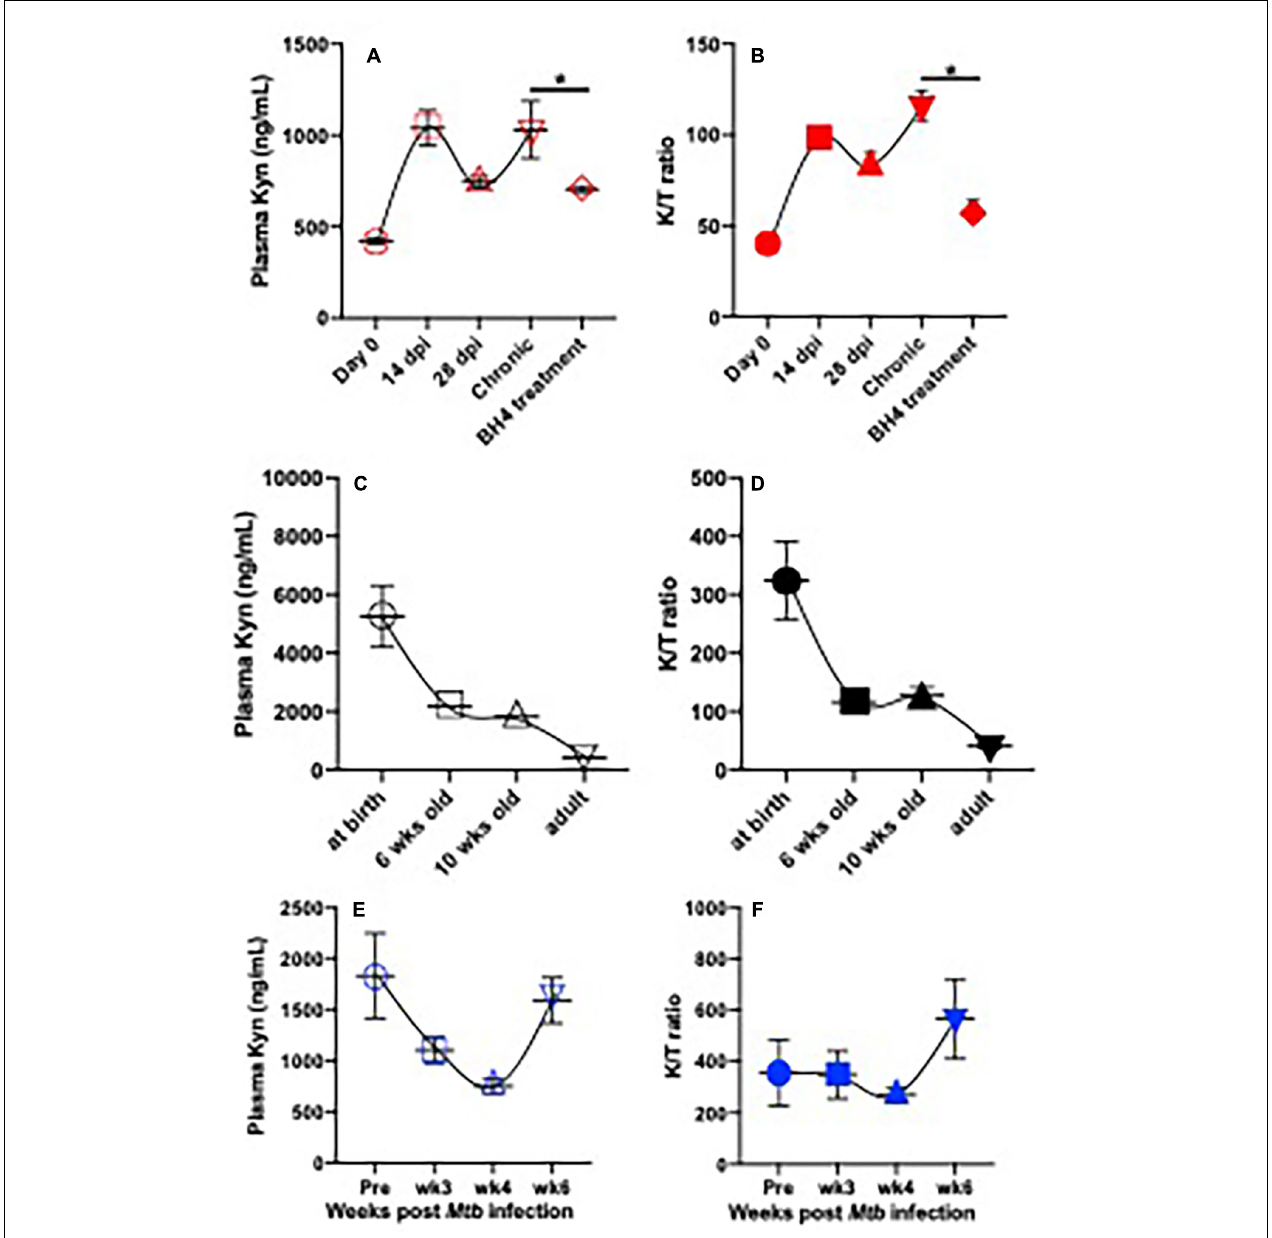
FIGURE 1 | Plasma IDO activity and kynurenine metabolite in SIV-infected adult rhesus macaques on BH4 treatment and their changes with ages or in infant macaques post Mycobacterium tuberculosis infection. (A,B) Dynamics of plasma Kyn and IDO activity (K/T ratio) in adult animal post SIV infection and effects of BH4 treatment on plasma Kyn levels and IDO activity; Indian rhesus macaques ( n = 4) were intravenously inoculated with SIVmac251 at 100TCID50. In chronic SIV infection ( > 3 months postinfection), macaques orally received BH4 (10 mg/kg/day, Schircks Laboratories, St. Gallen, Switzerland) for 1 month. ∗ p < 0.05, compared with untreated animals at chronic stage. (C,D) Dynamics of plasma Kyn and K/T ratios in animals with age; (E,F) dynamics of plasma Kyn and K/T ratio in infant macaque post Mtb infection. Infant macaques ( n = 3) were inoculated with 20 colony-forming units (CFUs) of M. tuberculosis CDC1551 by aerosol route. Plasma was collected to measure levels of Kyn and K/T ratio by ELISA according to instructions (ImmuSmol, Bordeaux, France). Kyn, kynurenine; Trp, tryptophan; IDO, indoleamine 2,3-dioxygenases; BH4, (6 R )-5,6,7,8-tetrahydro- L -biopterin dihydrochloride. K/T (Kyn/Trp) ratio represents IDO